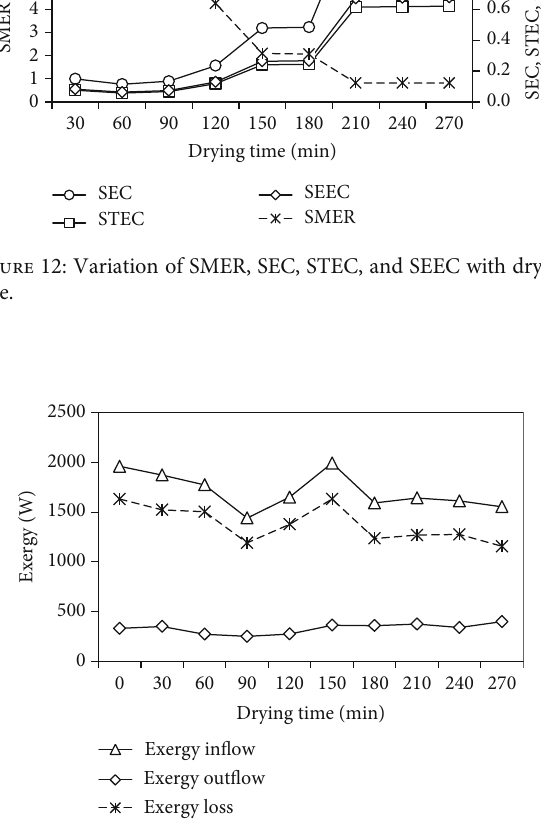
Figure 13: Variation of exergies with drying